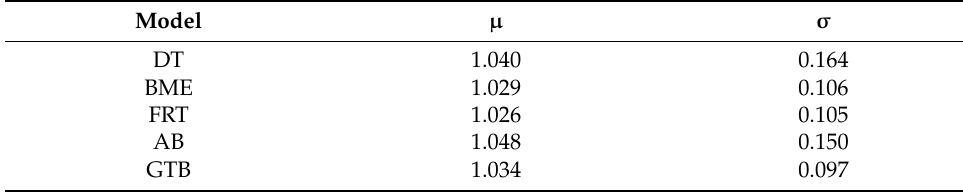
Table 7. Mean and standard deviation for testing